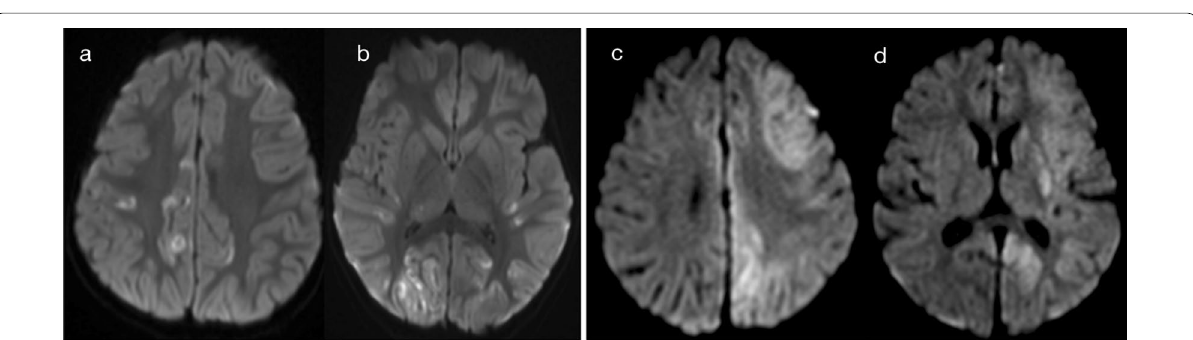
Fig. 5 Restricted diffusion in supratentorial grey matter—scattered lesions (Pattern 2A). Case 1: 3‑year‑old child with fever, headaches and